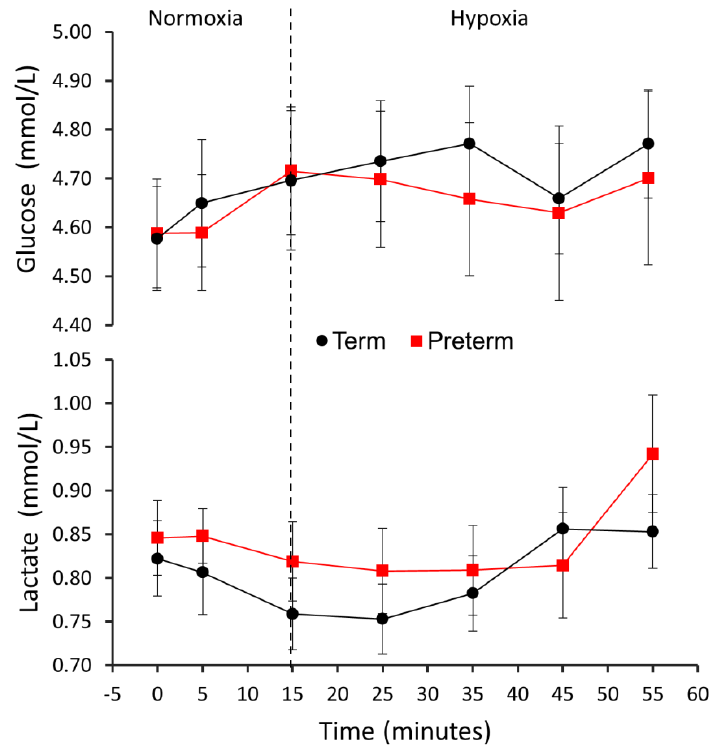
Figure 4. Serum glucose and lactate levels over the course of the PET experiment. The vertical dotted line represents the time when the oxygen level delivered to the subjects’ breathing masks was lowered from 21% to 12%. Pbirth status indicates the statistical significance of the effect of term vs. preterm group on glucose metabolic rate. Pgas indicates the statistical significance of the effect of normoxic vs. hypoxic air on glucose metabolic rate. Pinteraction indicates the statistical significance of the interaction of term vs. preterm group and normoxic vs. hypoxic air on glucose metabolic rate.